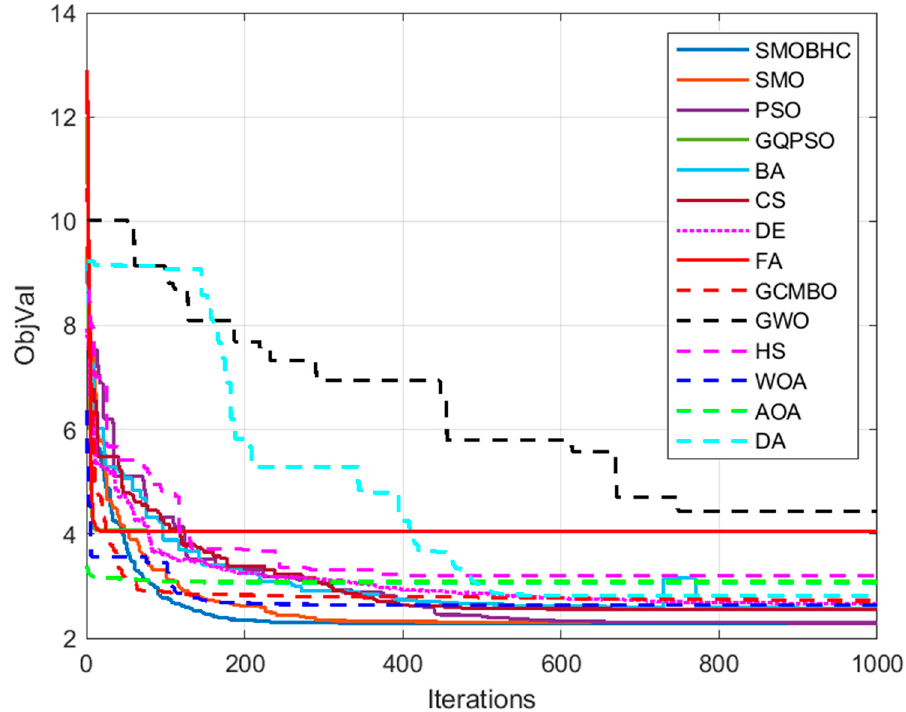
Figure 8. Comparative convergence curves of algorithms for battlefield 1 with 𝐷 = 30 .